Question: Condense the content of this figure into a single sentence.
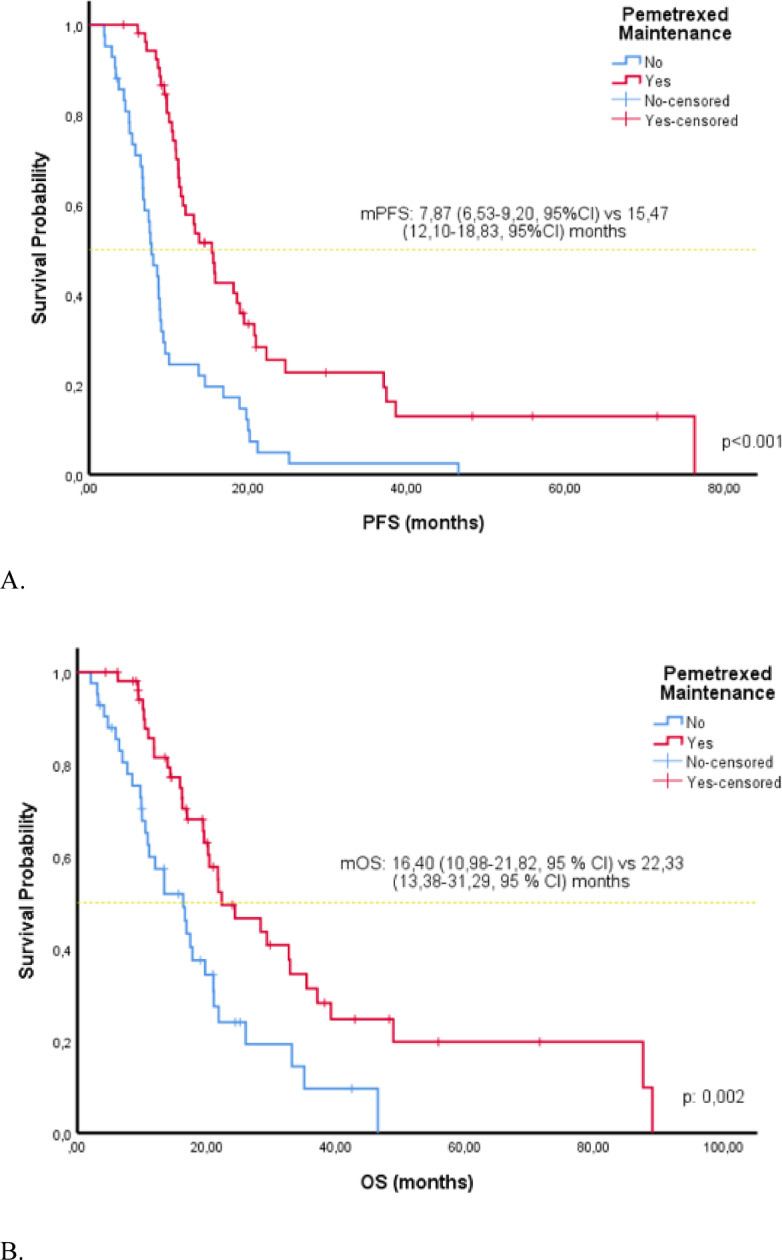
Answer: Kaplan–Meier curves for progression-free survival ( A ) and overall survival ( B ) according to maintenance pemetrexed therapy in the overall study population. mOS: median overall survival, mPFS: median progression-free survival.